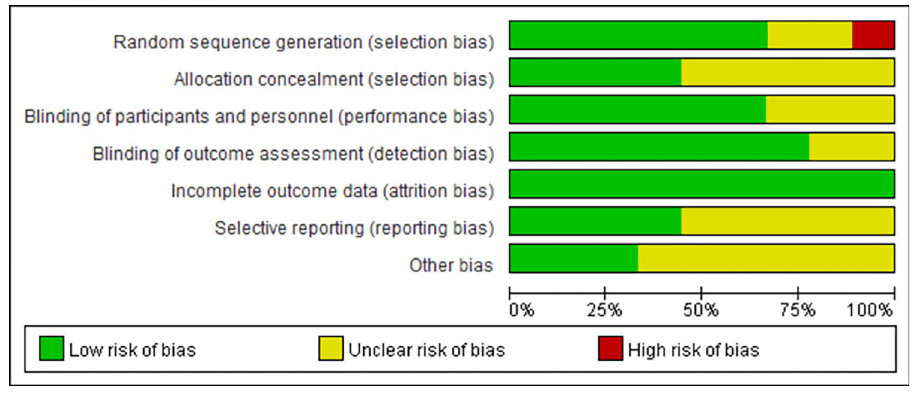
Fig 2. Risk of bias summary in